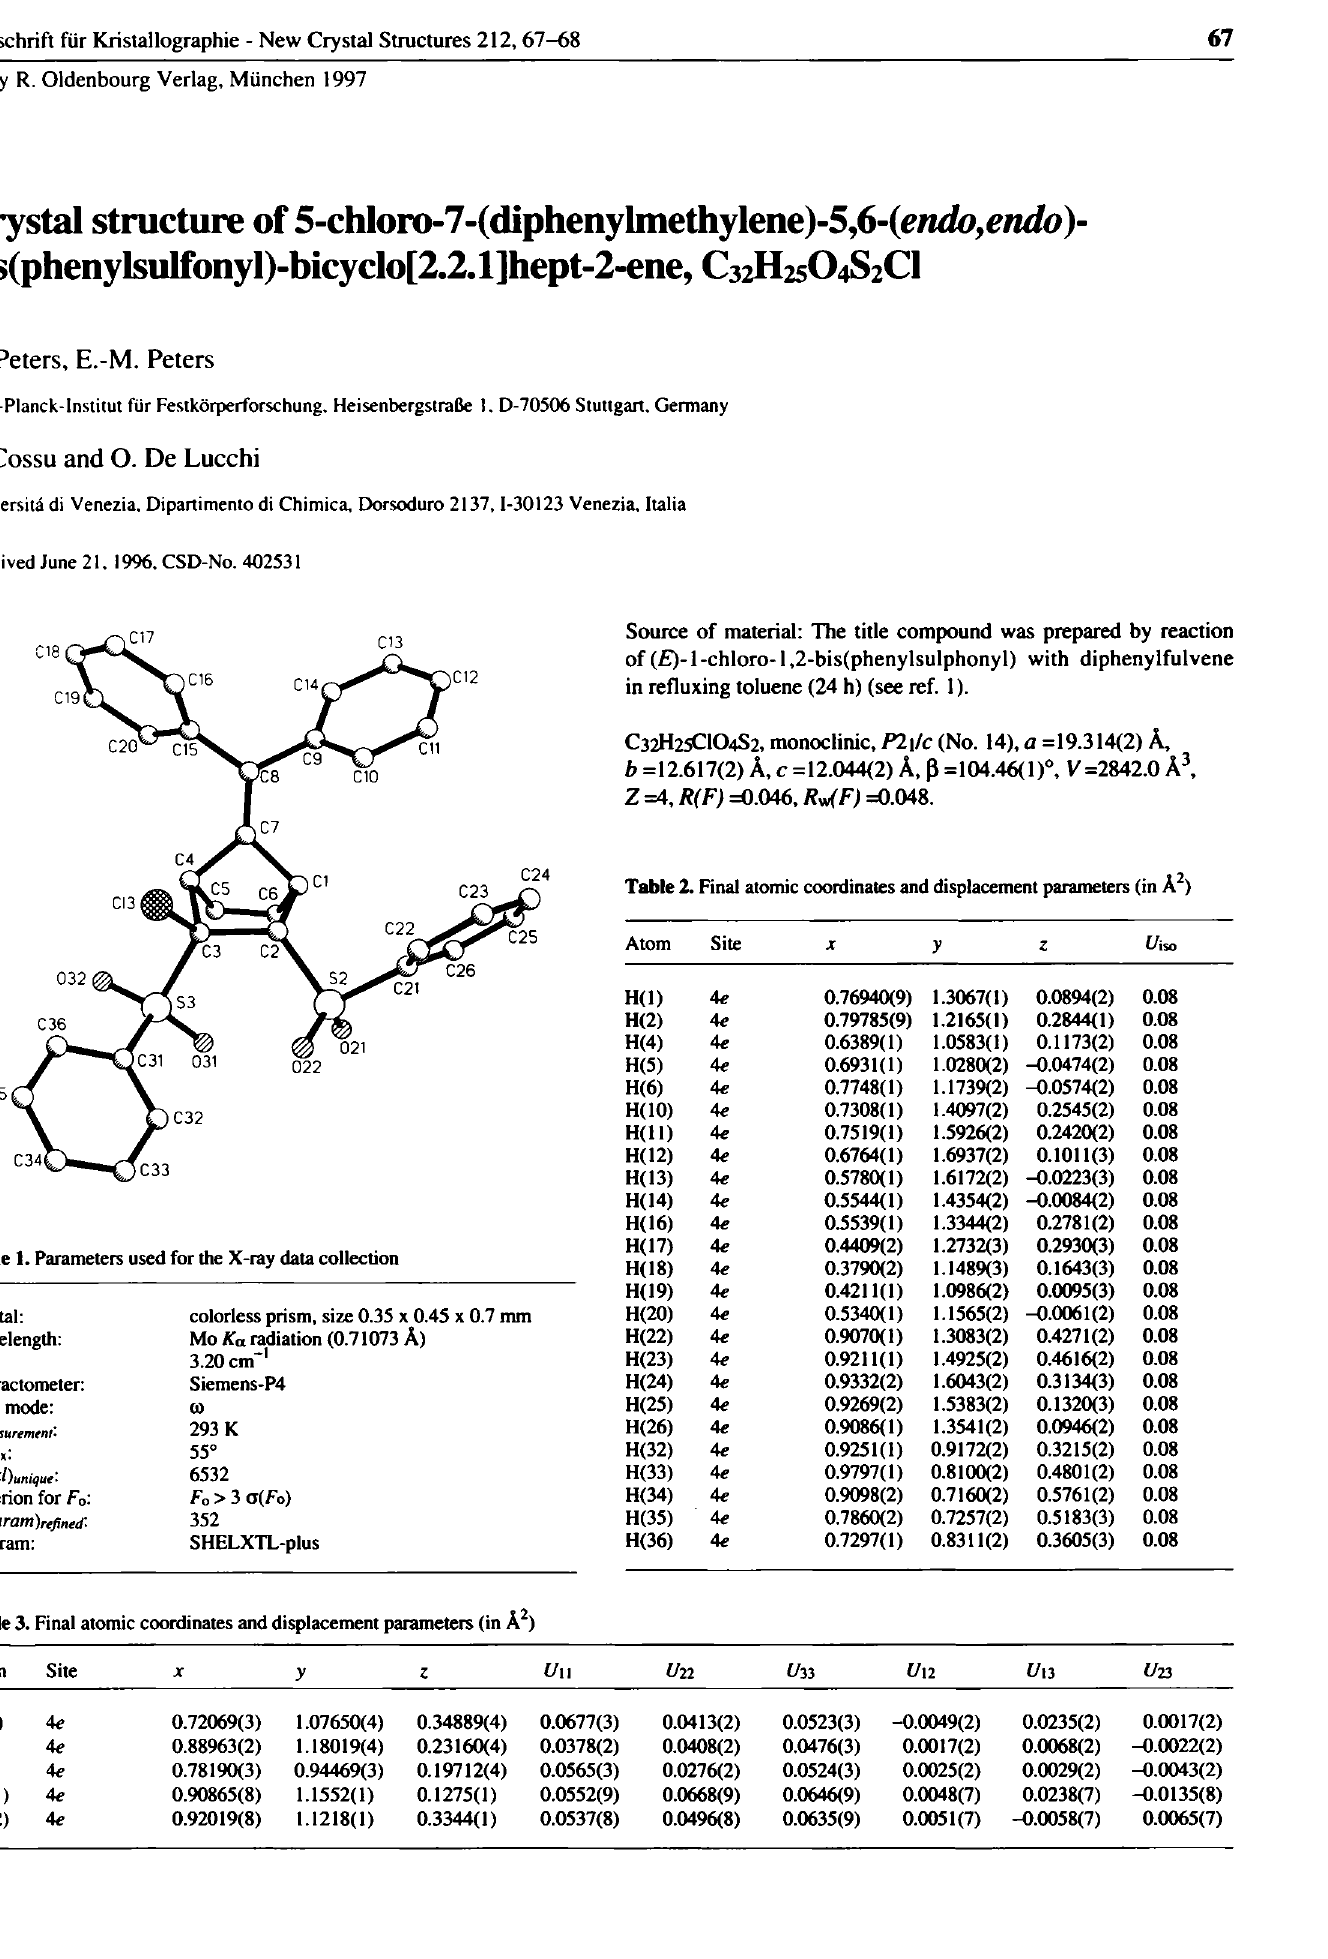
Table 3. Final atomic coordinates and displacement parameters (in A 2 )